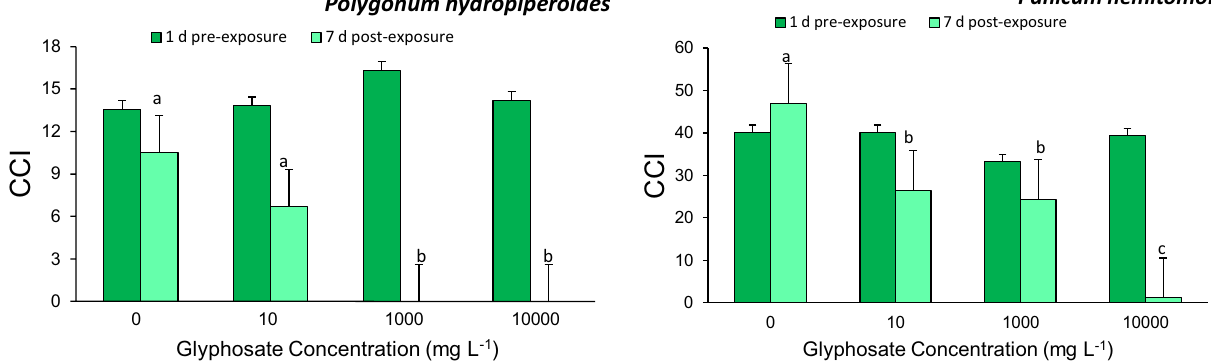
Figure 1. Leaf chlorophyll content index (CCI) values for Polygonum hydropiperoides and Panicum hemitomon . Bars represent treatment means ± SE for 10 and six replicates for P. hydropiperoides and P. hemitomon , respectively. Dark bars represent 1 d pre-exposure values; light bars represent 7 d post-exposure values. Lowercase letters represent significant differences across glyphosate treatments for species ( p < 0.05). Note the different scales for CCI for each species.